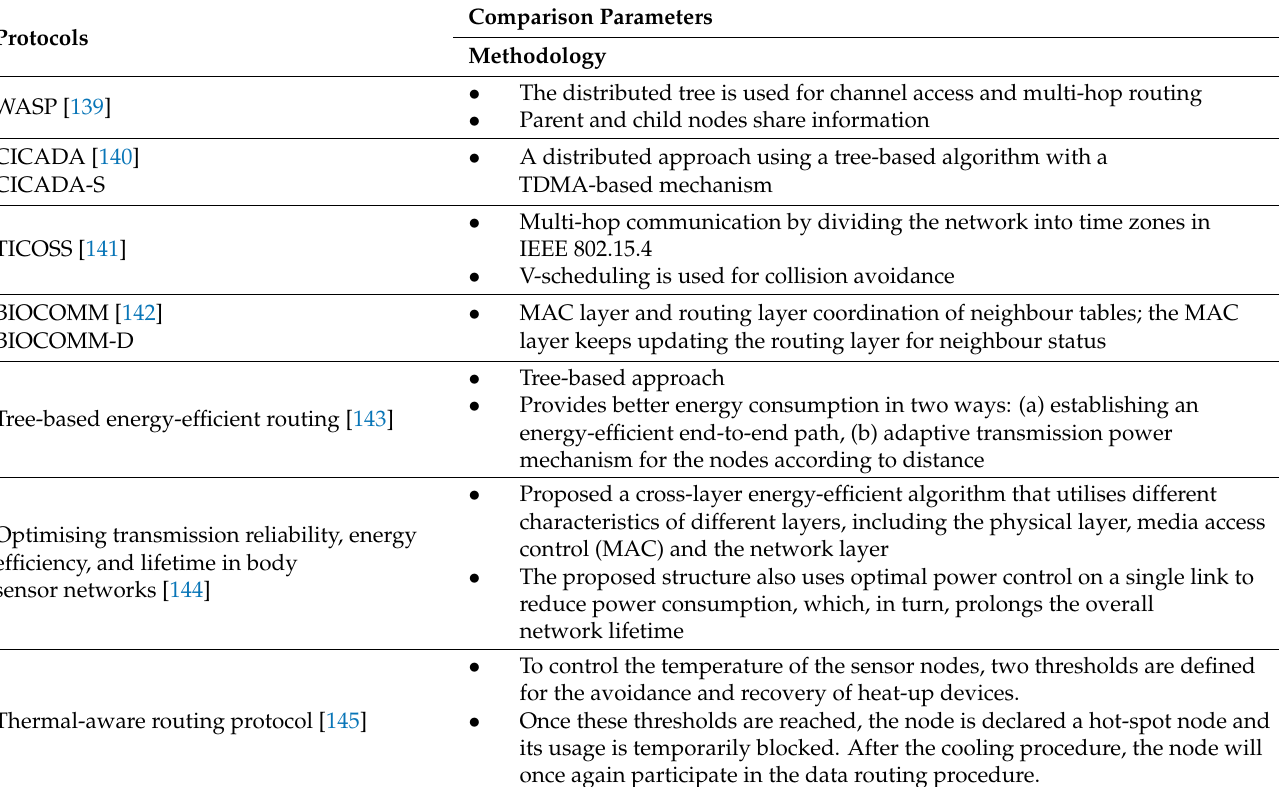
Table 10. Comparative analysis of cross-layer